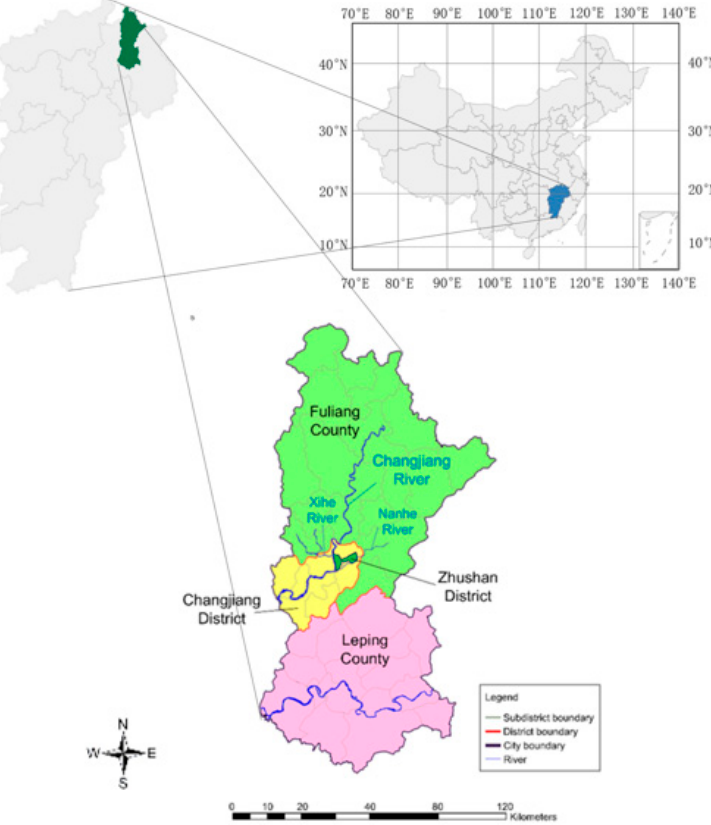
Figure 1. Geographic location of the study area.